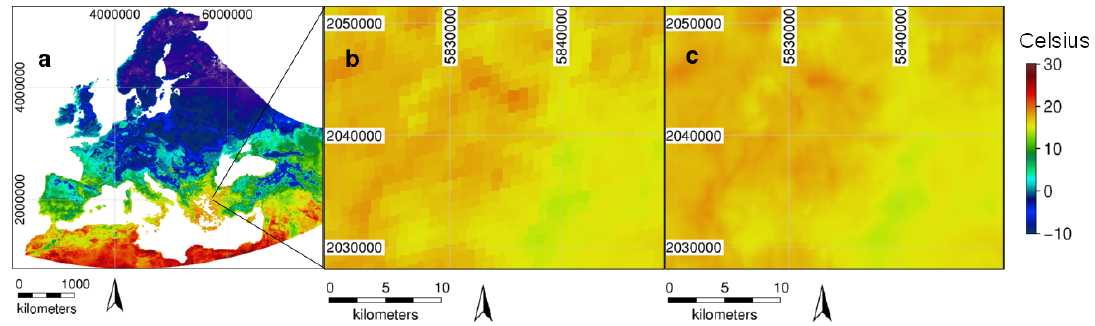
Figure 1 . Reconstructed land surface temperature; here, 1 January 2010, 10:30 am. Full extent ( a ), before ( b ) and after ( c ) spatial enhancement with auxiliary variables. All data are in the Lambert azimuthal equal area projection (EPSG (European Petroleum Survey Group) code: 3035). The extents in geographical degrees of (b) and (c) are approximately